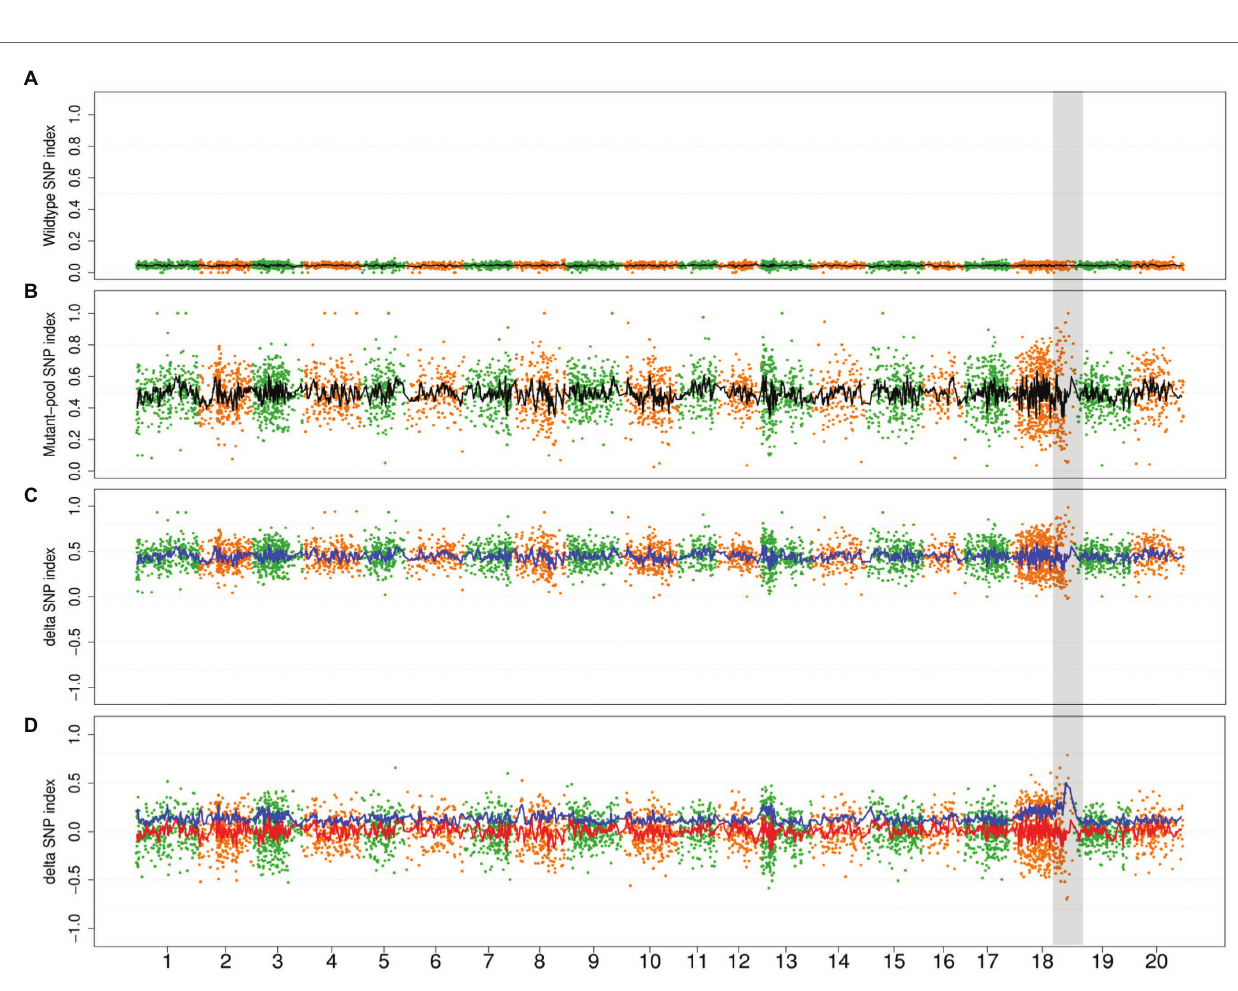
FIGURE 5 | Glyma.08G193200 was marked with green. (N) Schematic illustration of the genomic locus of GmRHD3 . Exons and introns are shown in boxes and lines, respectively. Mutation site for the Gmrhd3 was indicated. (O) The overall structure of full-length GmRHD3 . The number on the top indicates the corresponding amino acid positions. The triangle represents the mutation site of Gmrhd3 . (P) DNA sequencing peak chromatograms of genomic DNA of Gmrhd3 and wild type close to the mutation site. The mutation site was marked with pale green rectangle.